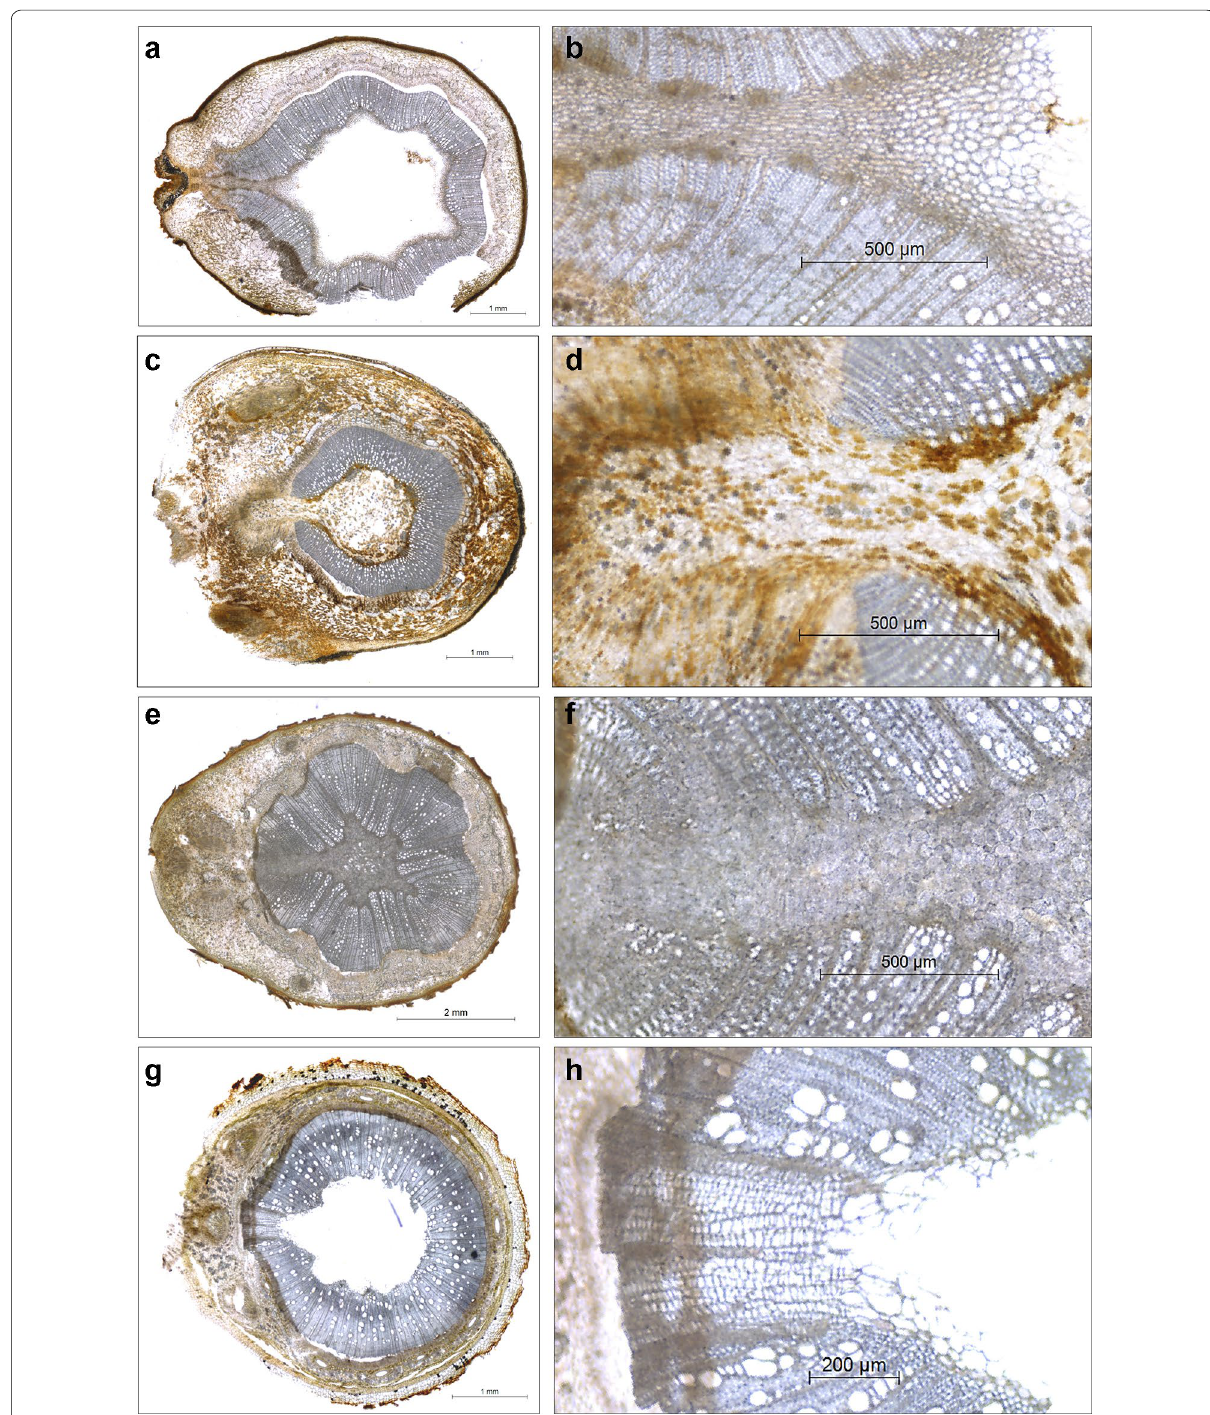
Fig. 5 Representative micrographs of stem transverse sections and node gaps of four species, including Juglans californica ( a , b ), Populus trichocarpa ( c , d ), Quercus robur ( e , f ), and Rhus aromatica ( g , h ). In all panels, a scale bar is